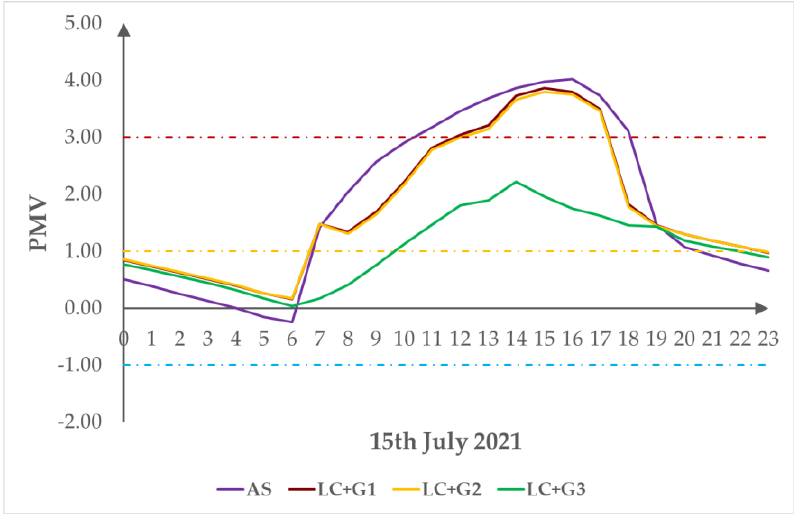
Figure 11. Daily PMV curves of R 5 .